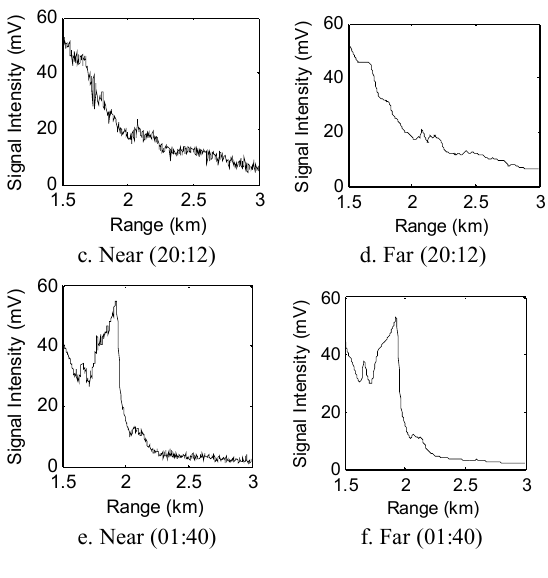
Fig. 2. Near and far range signal